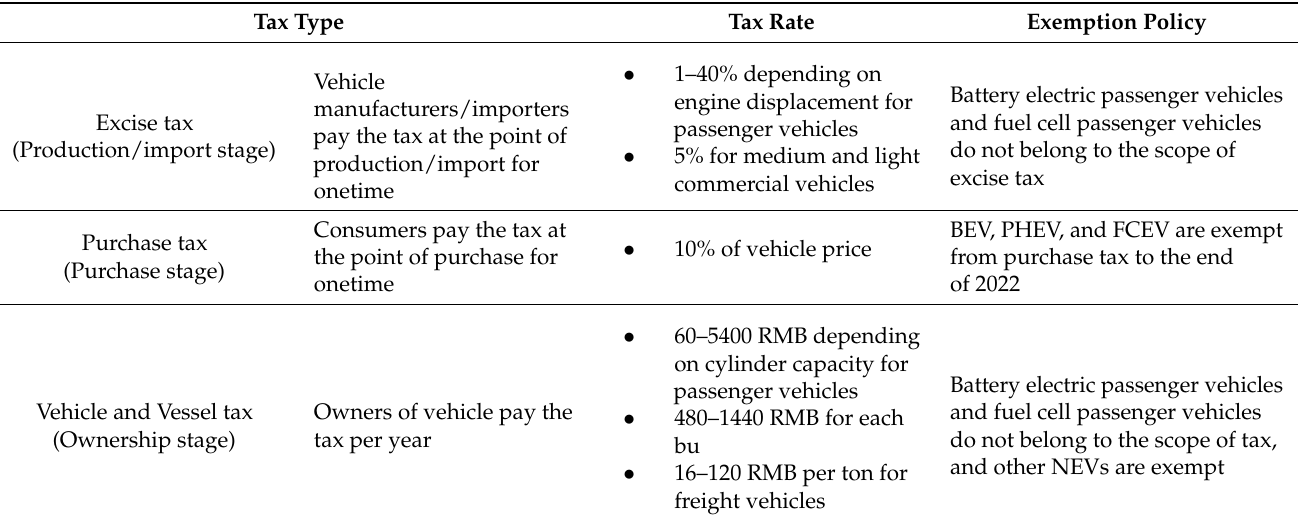
Table 1. China’s NEVs tax